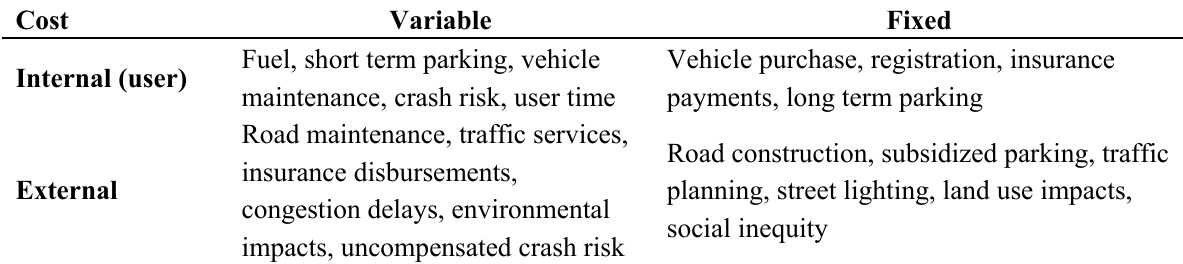
Table 5. Cost distribution and definition of motor